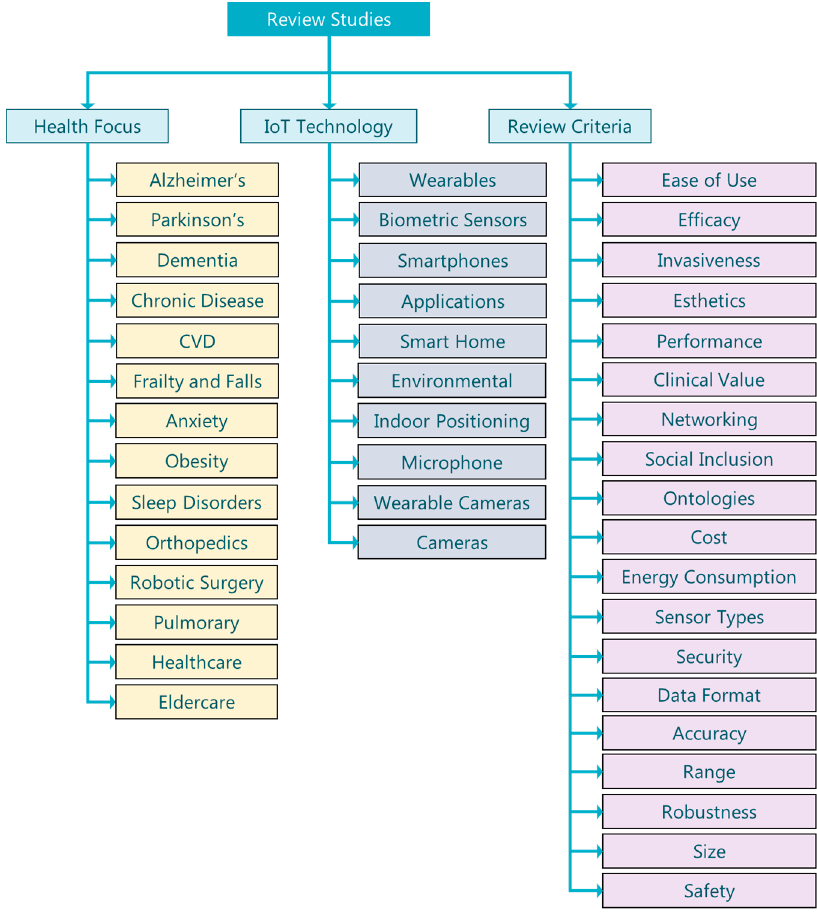
Figure 1. Review study classification taxonomy. IoT, Internet of Things; CVD, cardiovascular disease.